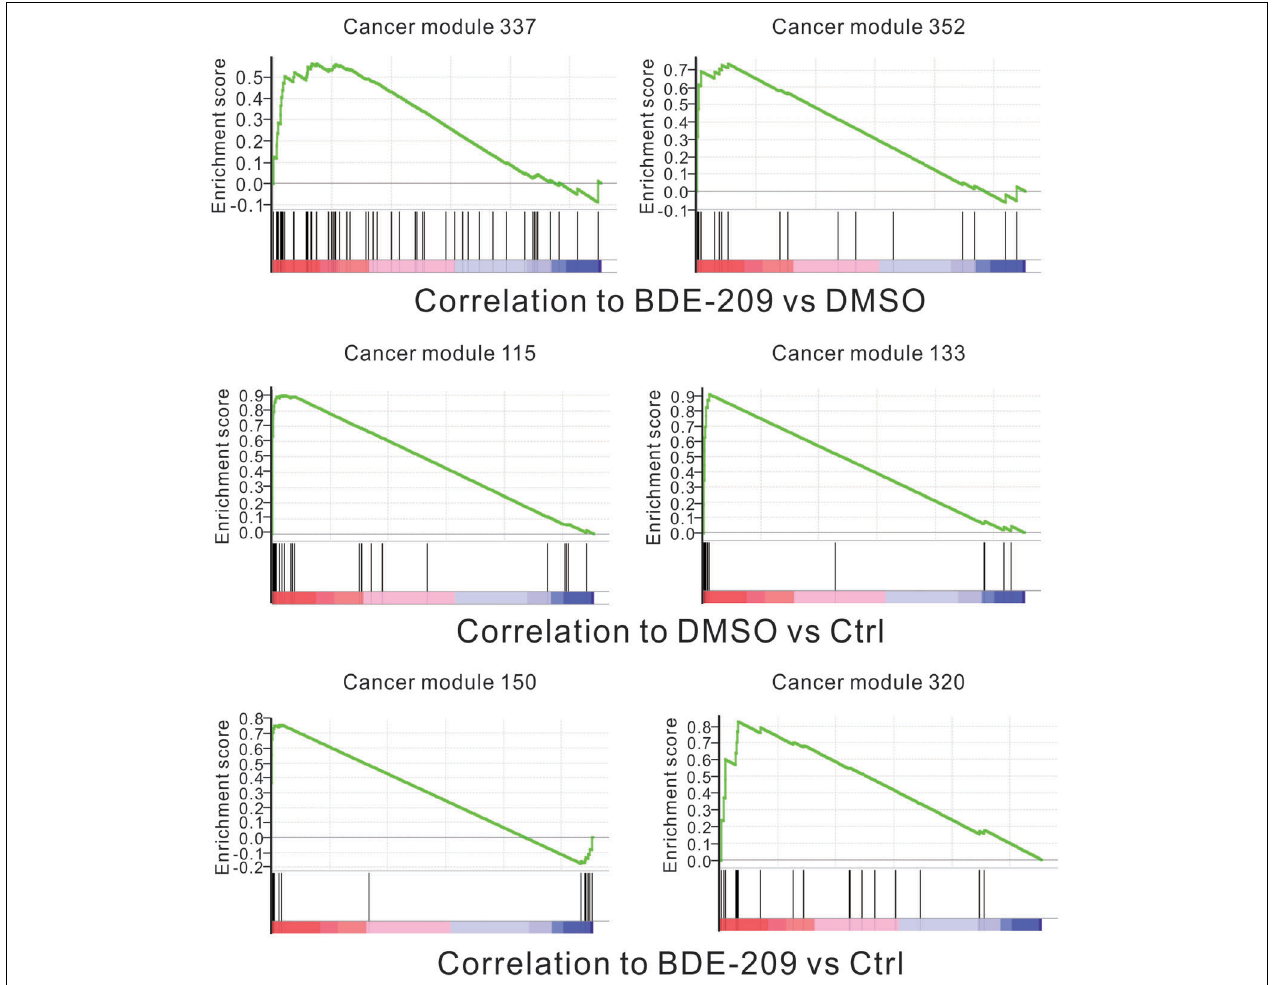
FIGURE 4 | Correlation between the enrichment of oncogenic signature genes and BDE-209 exposure. Top panel: genes are ranked by the expression ratio of BDE-209 dissolved in DMSO sample over DMSO sample. The genes of cancer module 337 and 352 are positively correlated with BDE-209 exposure. Middle panel: genes are ranked by the expression ratio of